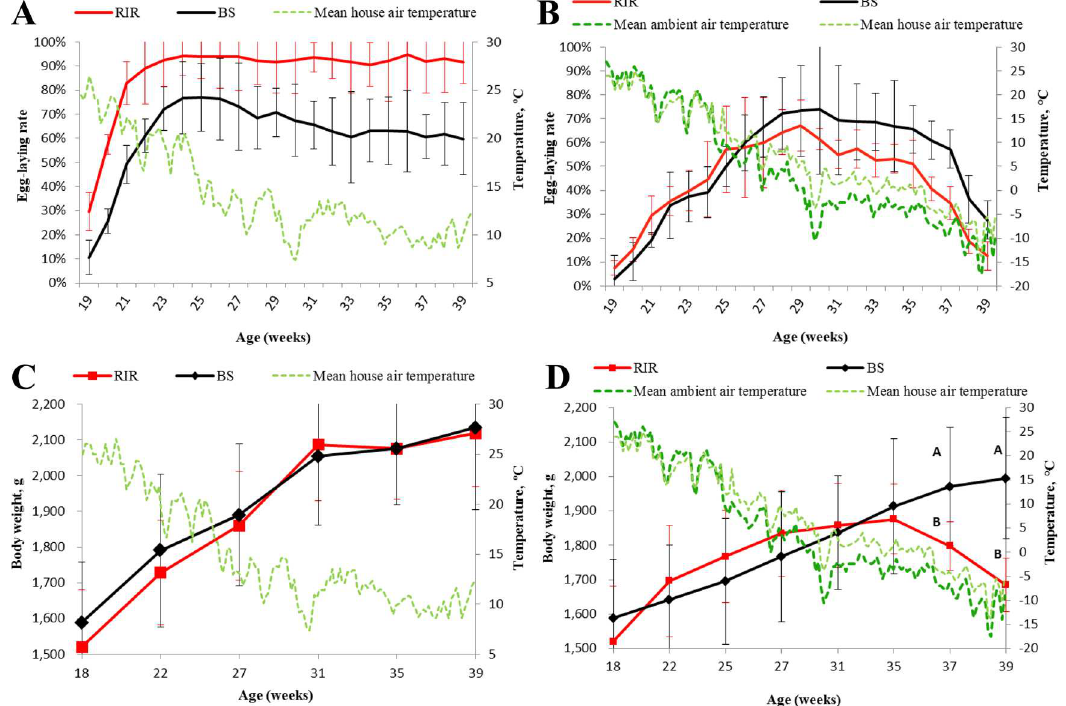
Fig 1. Weekly laying rates and body weights of BS and RIR chickens in warm and cold environments. (A, C) Weekly laying rates and body weights of the two breeds in warm environment. (B, D) Weekly laying rates and body weights of the two breeds in cold environment. Values are given as mean ± SD. At a given age in D, different letters denote a significant difference ( p < 0.01).